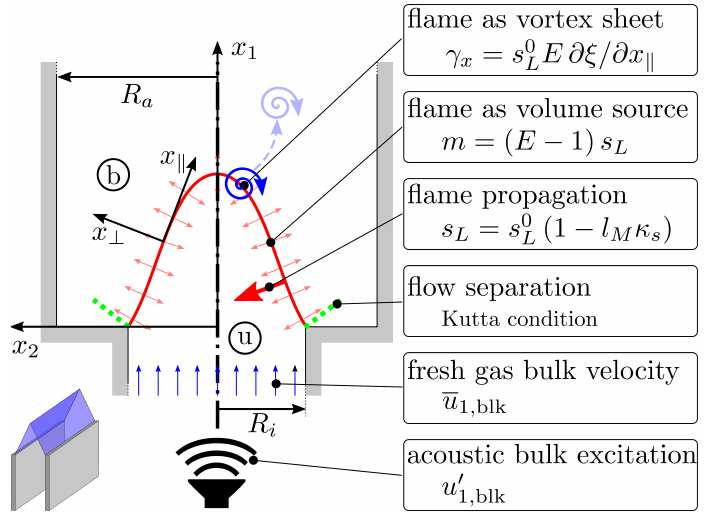
Figure 1. A laminar slit flame is stabilized above a planar jet of unburned mixture, as illustrated in 3D in the lower left corner of the picture. The unburned (“u”) fuel/air premixture flows with bulk flow velocity u 1,blk and is subjected to upstream bulk velocity perturbations u (cid:48) . The flame propagates 1,blk normal to itself with speed s L , which may depend on flame front curvature κ , and acts as a volume source of strength m . Two coordinate systems are used, namely laboratory coordinates ( x 1 , x 2 ) and ) where x flame-aligned coordinates ( x , x points in the local flame normal direction towards the ⊥ ⊥ (cid:107) burned gas